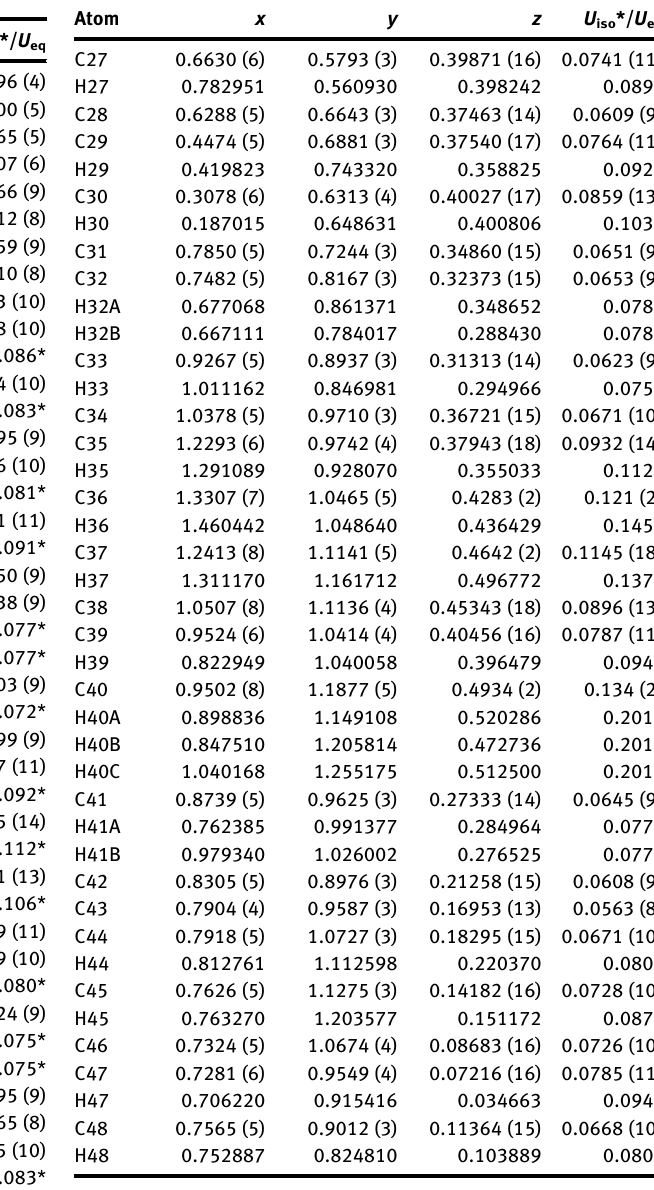
Table  : Fractional atomic coordinates and isotropic or equivalent isotropic displacement parameters (Å 